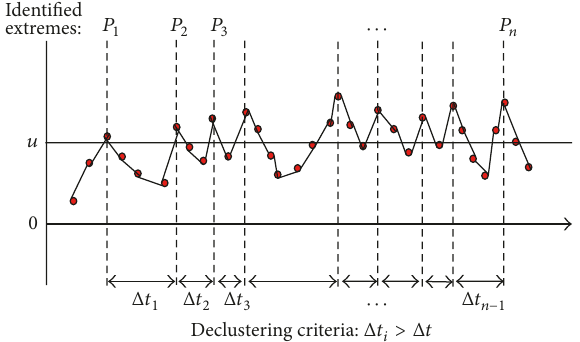
Figure 7: Illustration of declustering process in a time series data.